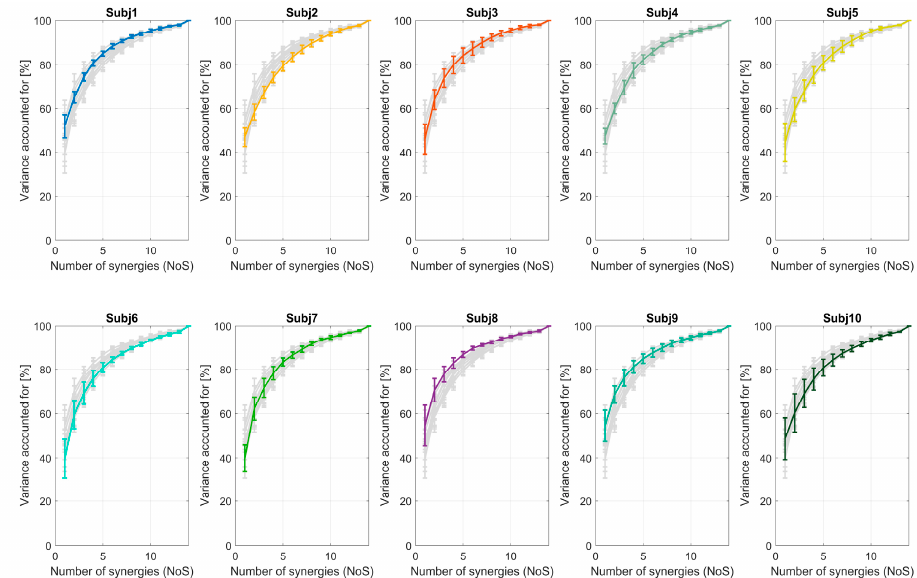
Figure 9. For each of the ten subjects, the amount of reconstructed VAF is portrayed against the number of extracted synergies. In each subplot, we portray one subject (colored line) compared to all the other 9 subjects (gray lines). Mean and standard deviation are shown representing variability between the VAF values of 5 sessions of the same